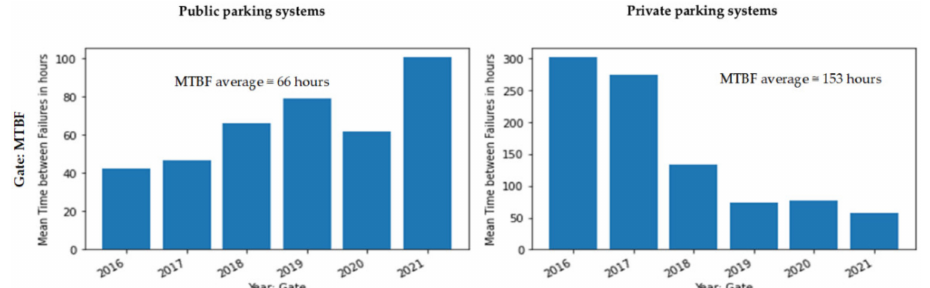
Figure 14. Mean time between failures (MTBF) in hours for all gate failures for public ( left ) and private ( right ) parking systems.